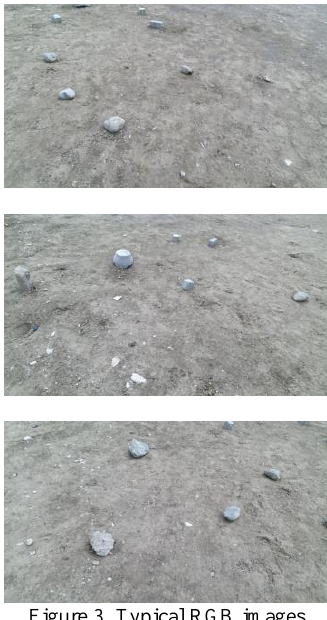
Figure 3. Typical RGB images